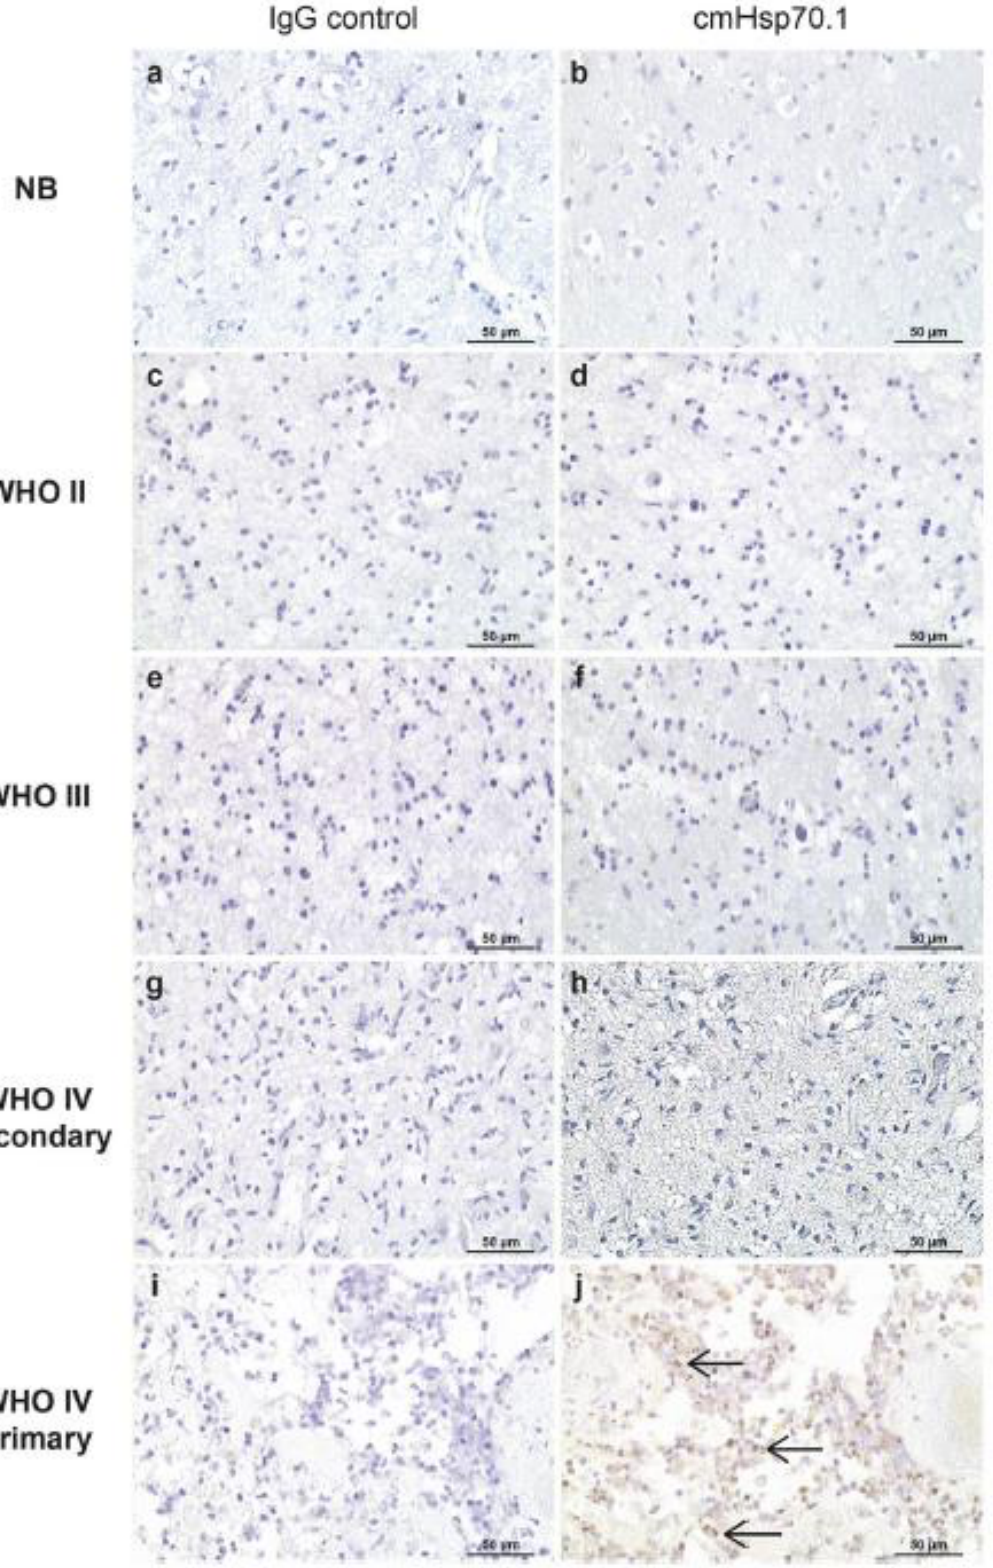
Figure 6. Membrane Hsp70 expression in the non-neoplastic brain ( b ), diffuse astrocytoma ( d ), anaplastic astrocytoma ( f ), secondary GBM ( h ), and primary GBM ( j ) and corresponding negative controls ( a , c , e , g , i ) as determined by IHC. Magnification: ×20. Scale bar 50 µm [82].